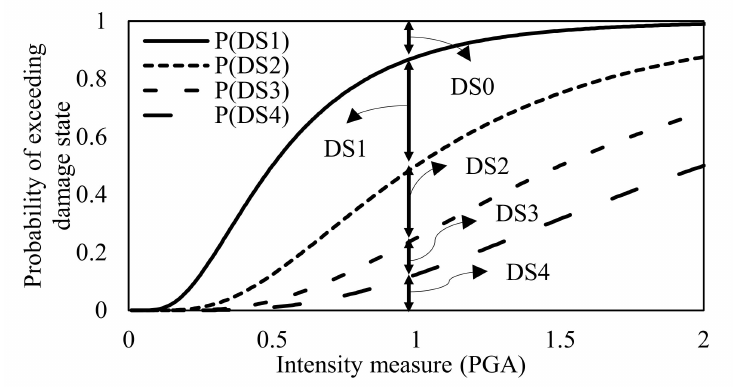
Figure 4. Damage state assessment under seismic